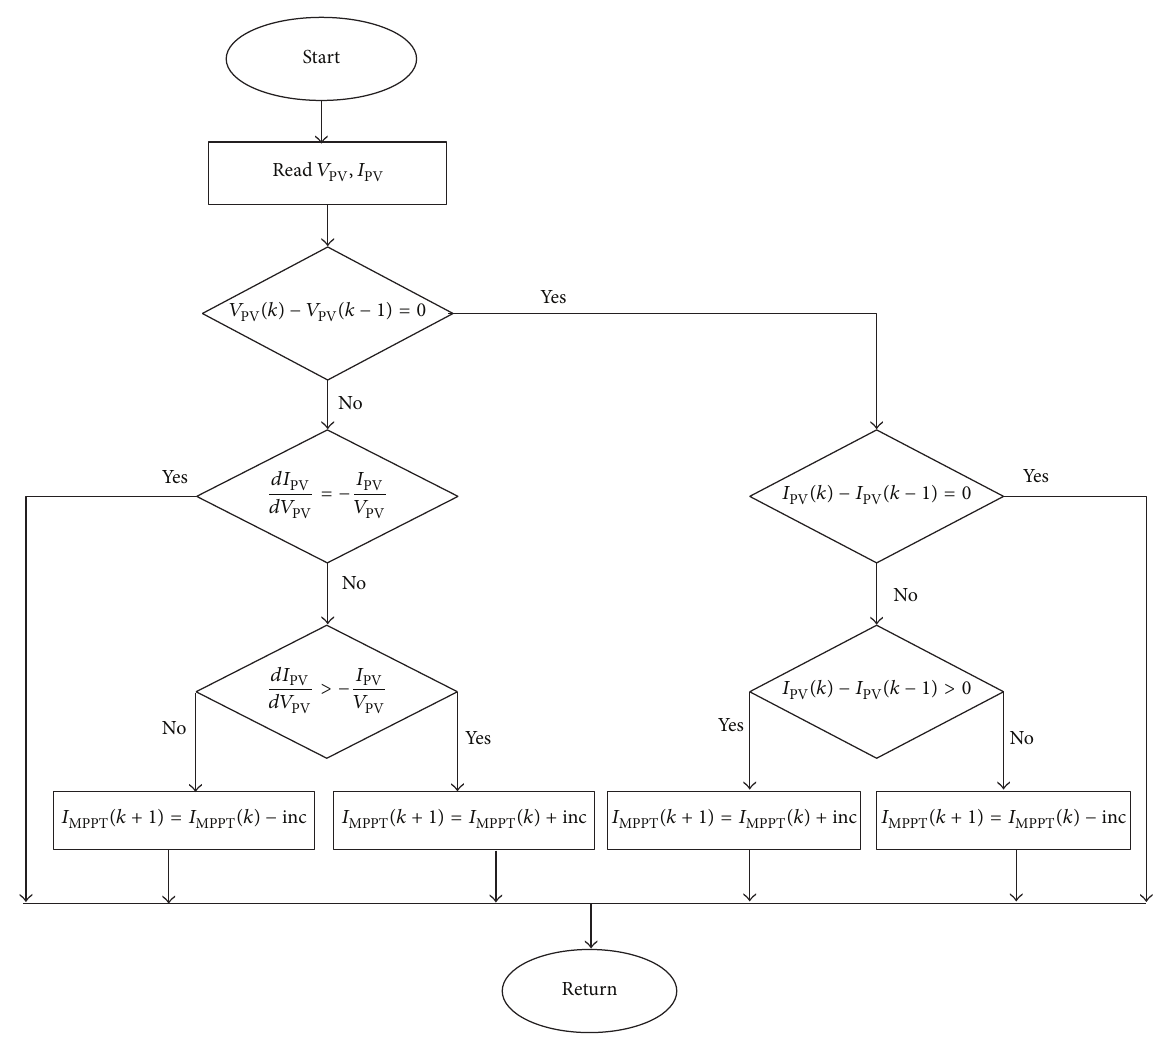
Figure 5: Flowchart of the incremental conductance